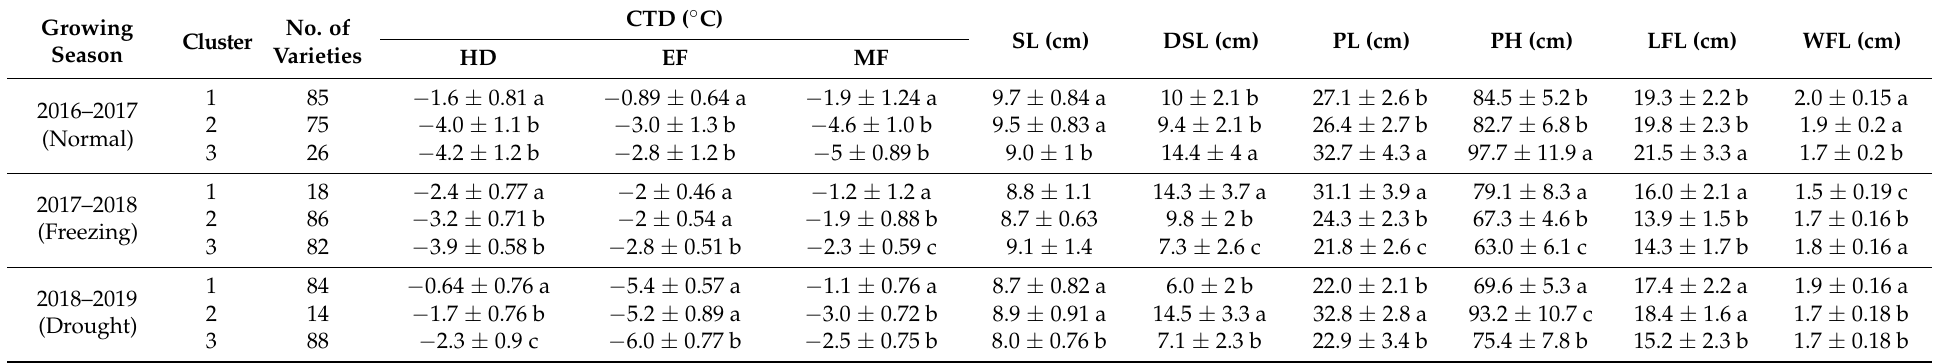
Table 4. Multiple comparisons of CTD and structural traits among the groups of wheat varieties based on clustering the CTDs at the three growth stages and canopy structural